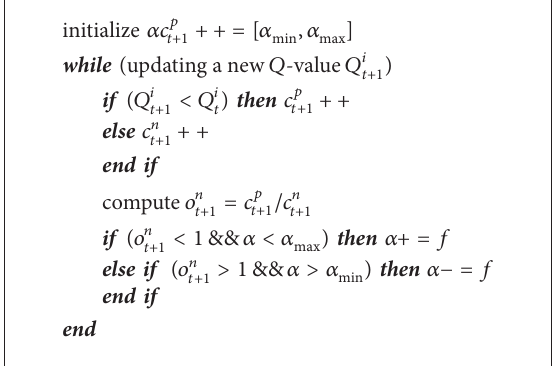
Algorithm 2: Counterapproach algorithm at SU node 𝑖 .